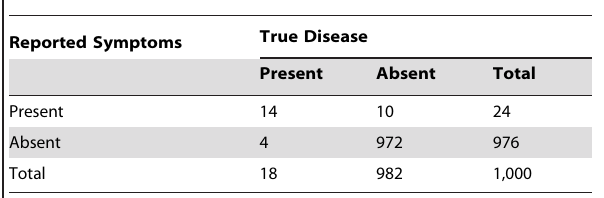
Table 4. Distribution of cases of ‘‘true pneumonia’’ according to caregiver report of ‘‘suspected pneumonia’’ (test) and true disease status when test sensitivity is 80% and specificity is 99%.